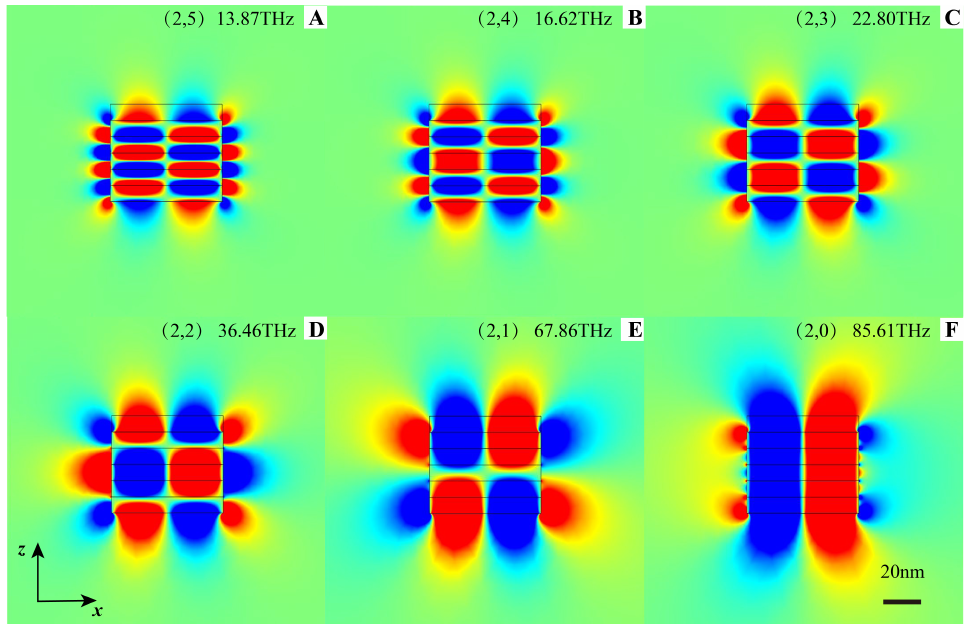
Figure 4. Resonate frequency with different mode order. Electric field E x of six cavity modes (2, m z ) with different resonate frequencies but at the same cavity size [62, 54]